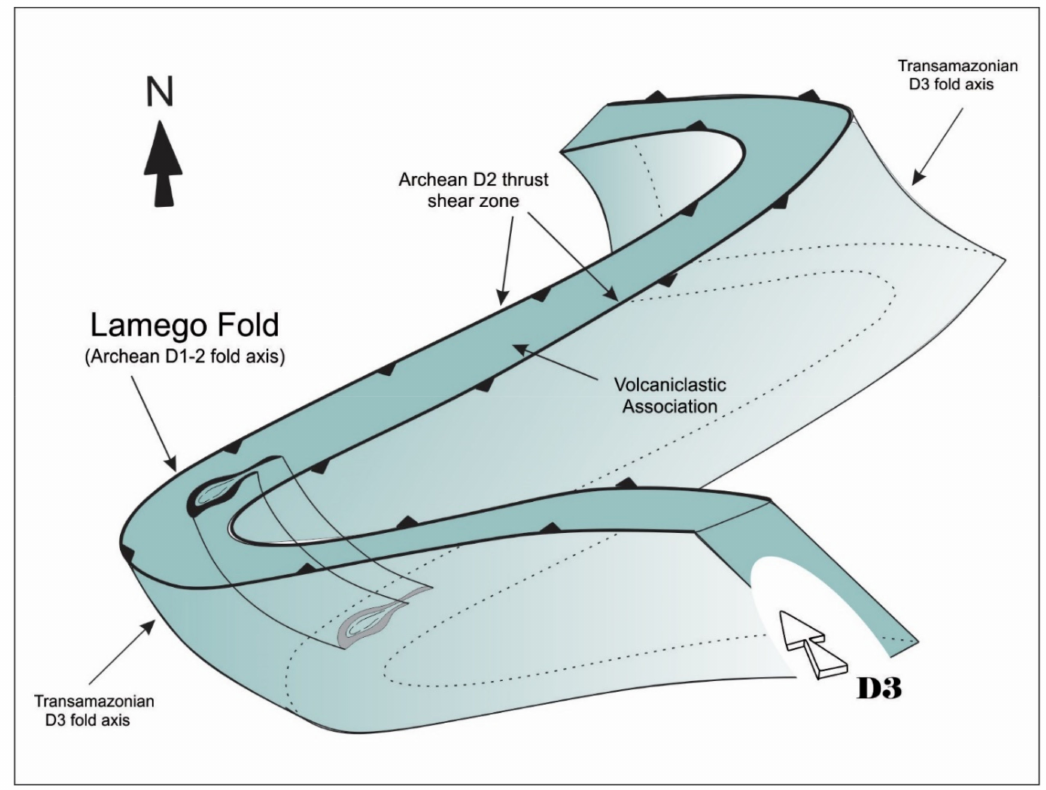
Figure 16. The D1–D2 Archean Lamego intrafolial fold in the flank of a great D3 Transamazonian fold. Note the parallelism between the two folding